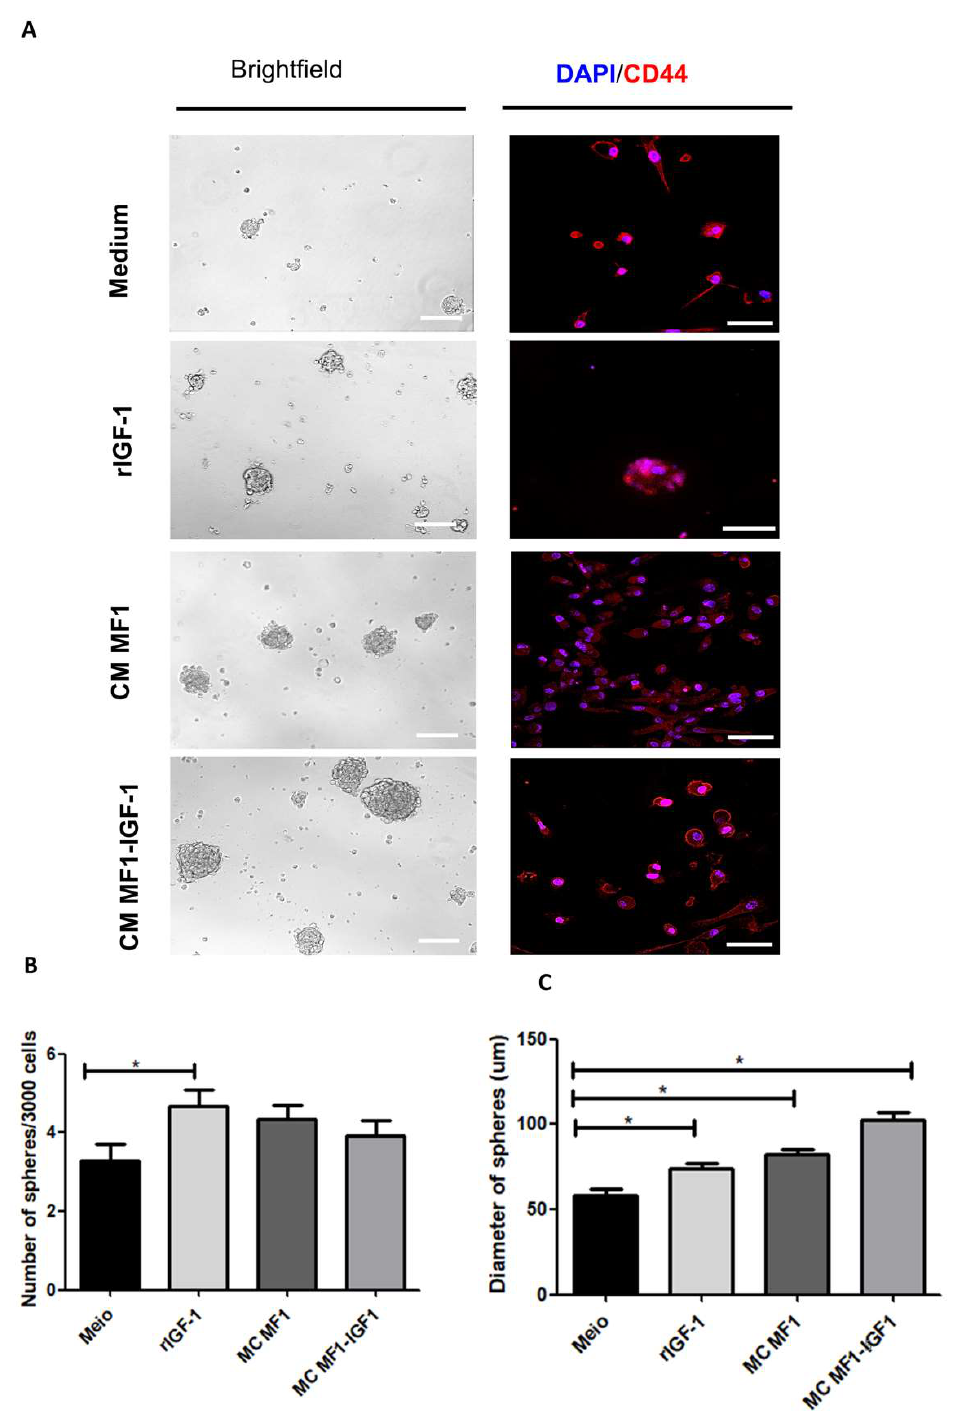
Figure 5. Tumorsphere formation assay. ( A ) Phase contrast images (left) showing morphologies of tumorspheres formed after 8 days under stimulation with rIGF-1 or conditioned media. Spheres were dissociated and immunostaining was performed (right) for detection of cancer stem cell marker CD44 (red) and DAPI for nuclei staining (blue). Bars: 200 µ m (phase contrast images; left) and 50 µ m (fluorescence images; right). ( B , C ) Quantification of the number ( B ) and diameter ( C ) of tumorspheres formed under di ff erent conditions. Data are presented as means ± SDs, bars represent comparisons between respective groups and (*) denotes statistical significance after applying the one-way ANOVA and Dunnett’s post-test, p < 0.05. CM: Conditioned